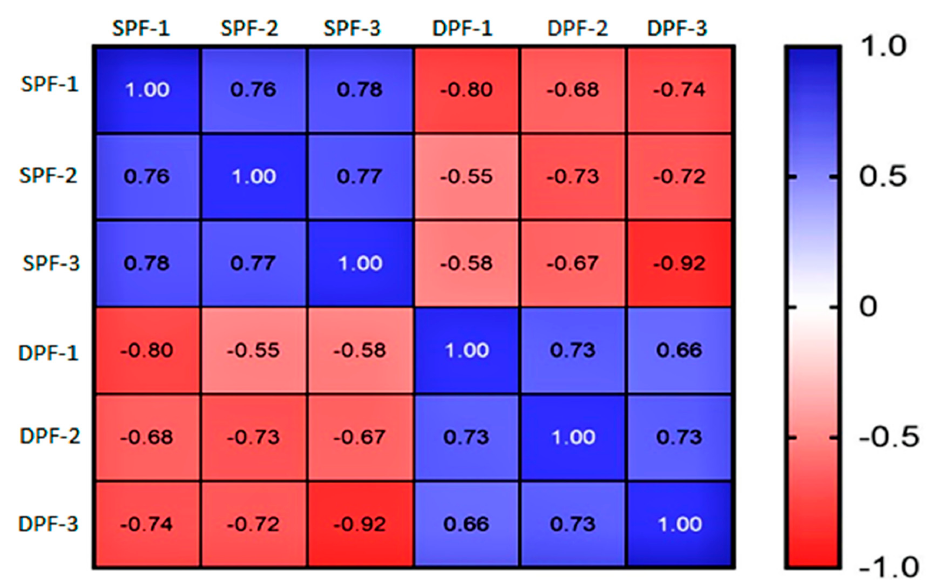
Figure 2. Correlation matrix. The correlation matrix is showing a higher correlation among the replicates of each experi- mental group, thereby validating the efficiency of proteomics data. SPFs stand for the replicates of small primary follicles and DPFs for developed primary follicles. SPFs and DPFs: Small and developing primary follicles